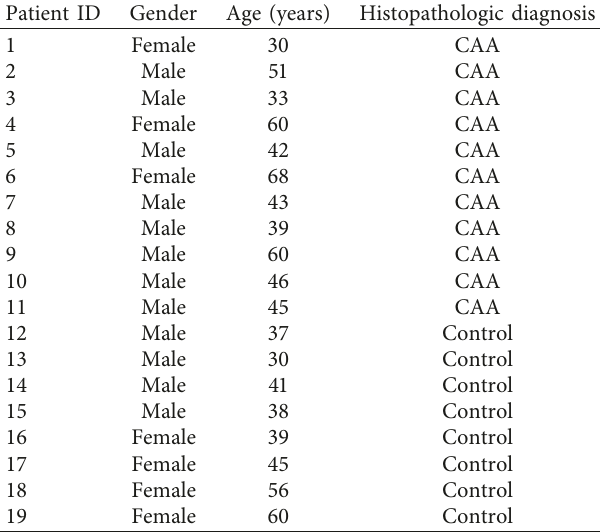
Table 1: Clinical and demographic characteristics of patients